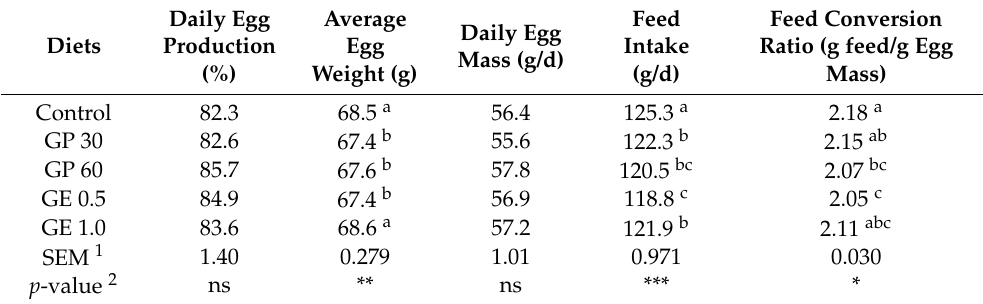
Table 3. Effect of grape pomace (GP) and grape extract (GE) at different dietary concentrations (g/kg) on egg production, egg weight, egg mass, feed intake and feed conversion ratio in 50- to 54-week-old laying hens.